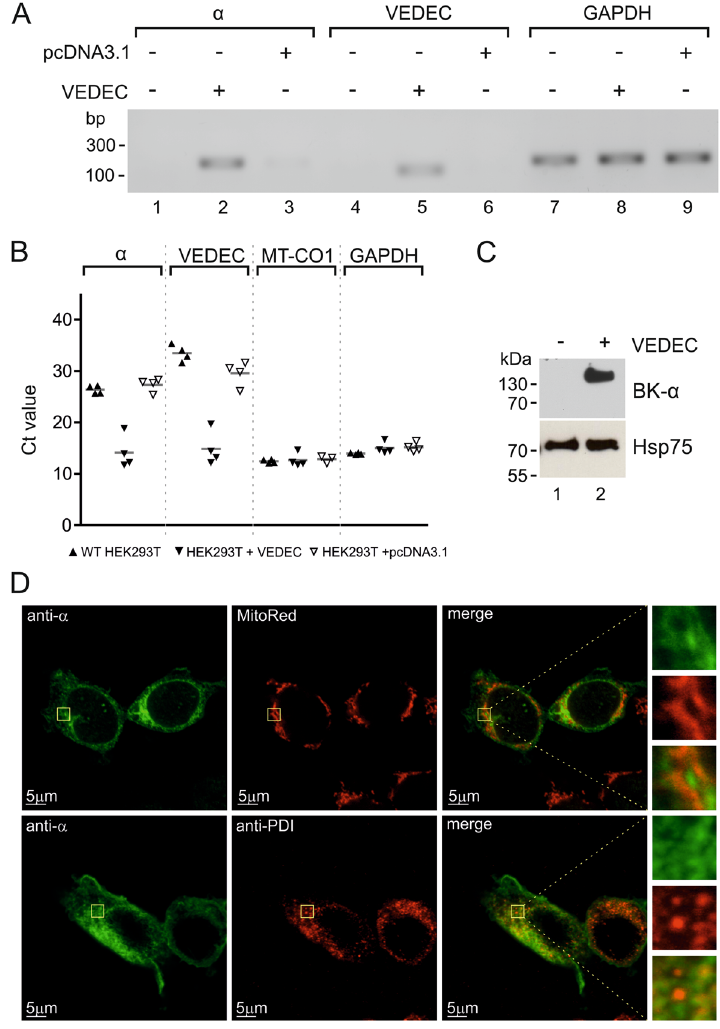
Figure 6. Analysis of the presence of the BK Ca α subunit in wild-type and VEDEC transiently transfected HEK293T cells. ( A ) Analysis of selected gene expression using qualitative PCR. ( B ) Real-time PCR analysis of the expression levels of selected genes. ( C ) Western blot analysis of the BK Ca pore-forming subunit in the mitochondrial fraction of wild-type and transfected cells. ( D ) Localization of VEDEC in HEK293T cells after transient transfection. Confocal images of cultured cells stained with MitoRed as a mitochondrial marker (upper panel, red channel) and an anti-PDI antibody as an endoplasmic reticulum marker (lower panel, red channel). The pore-forming α subunit was stained with an anti-BK α antibody (green channel). The superimposition of the two signals revealed the partial mitochondrial and ER localization of the BK Ca α subunit